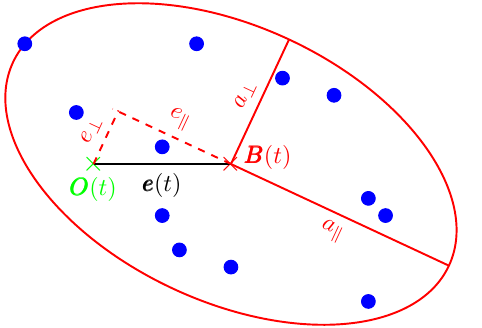
Figure 16. Illustration of the forecast error and the anisotropic search area. Blue dots represents the position of one member, while the barycentre of the ensemble (its mean) is B (t) . The observation O (t) is in green and the forecast error is defined in Eq. (12). See text for definitions of the search ellipse and anisotropy ratio.